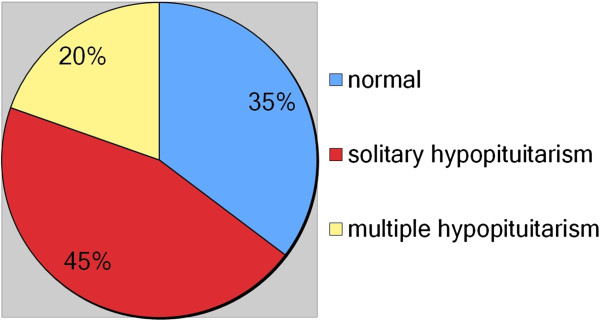
Frequency of pituitary deficiencies.